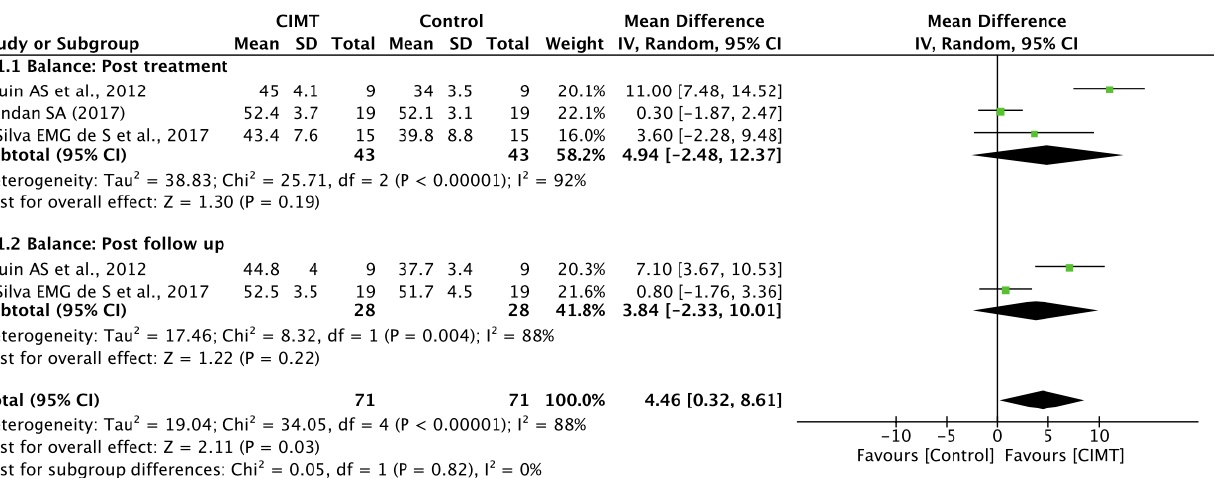
Figure 3. Gait speed: post-treatment and post-follow-up. (Tedla, 2022)